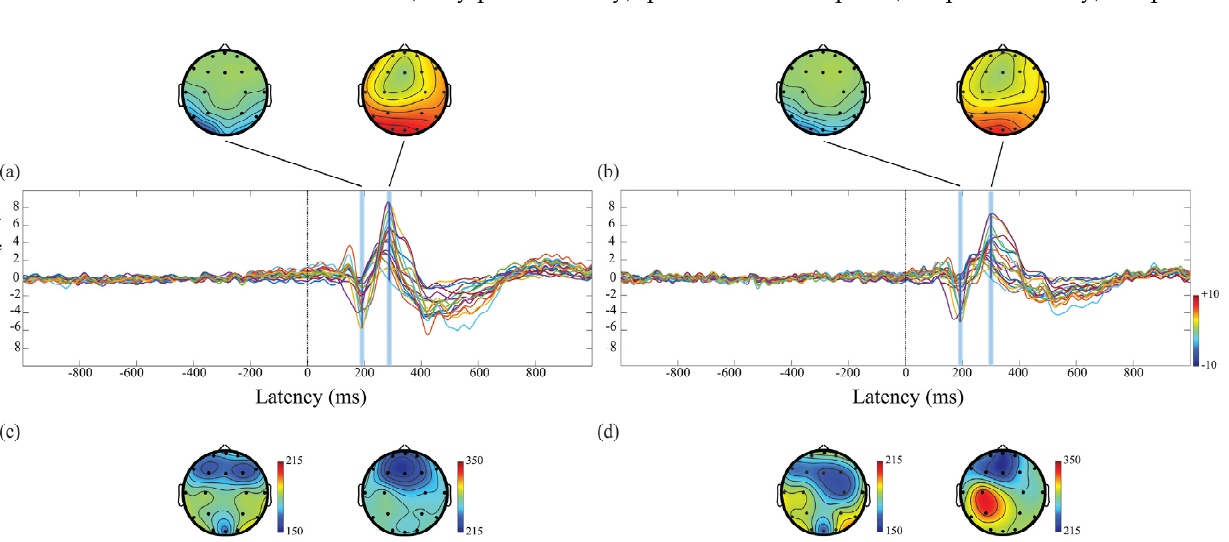
Figure 4. Grand average ERPs evaluated in pre- ( a ) and post- ( b ) sessions for all 19 channels investigated have been superimposed before and after the stimulus. The scalp maps show the topographic distributions of voltage values, color-coded and recorded at the times of N100 and P200 peaks post-stimulus onset. The scalp maps of ( c , d ) show the topographic latency of the N100 and P200 peaks, pre- ( c ) and post- ( d ) SD.